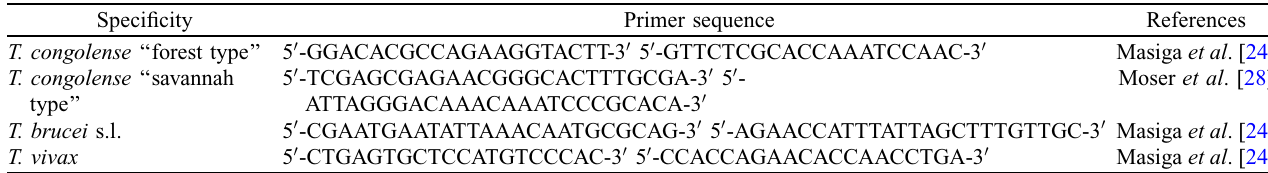
Table 1. Primers used for the identification of different trypanosome